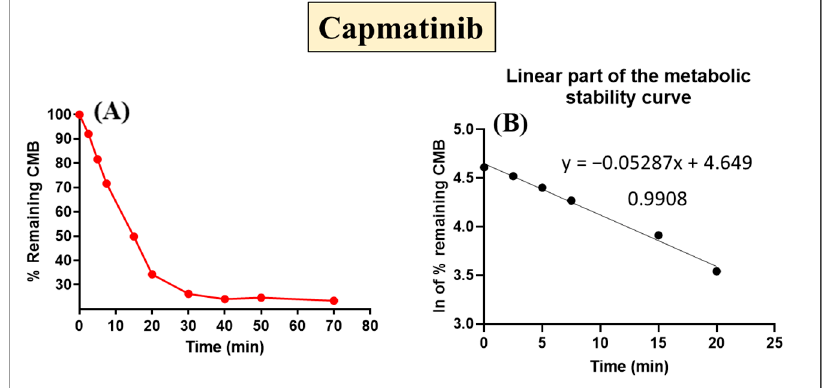
Table 7. Metabolic stability of capmatinib ( CMB). Time in Min.